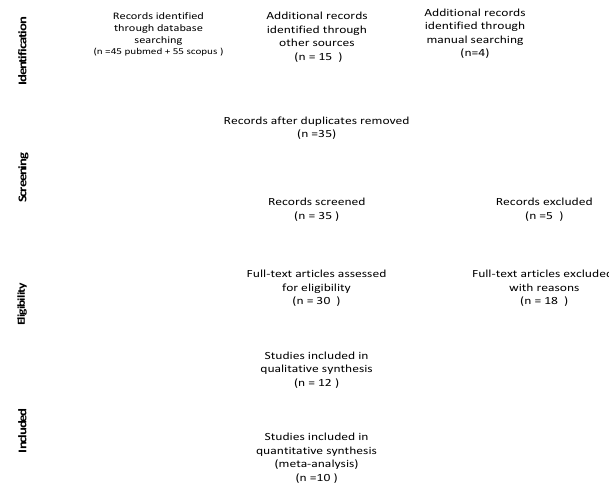
Figure 2. Prisma flow diagram.